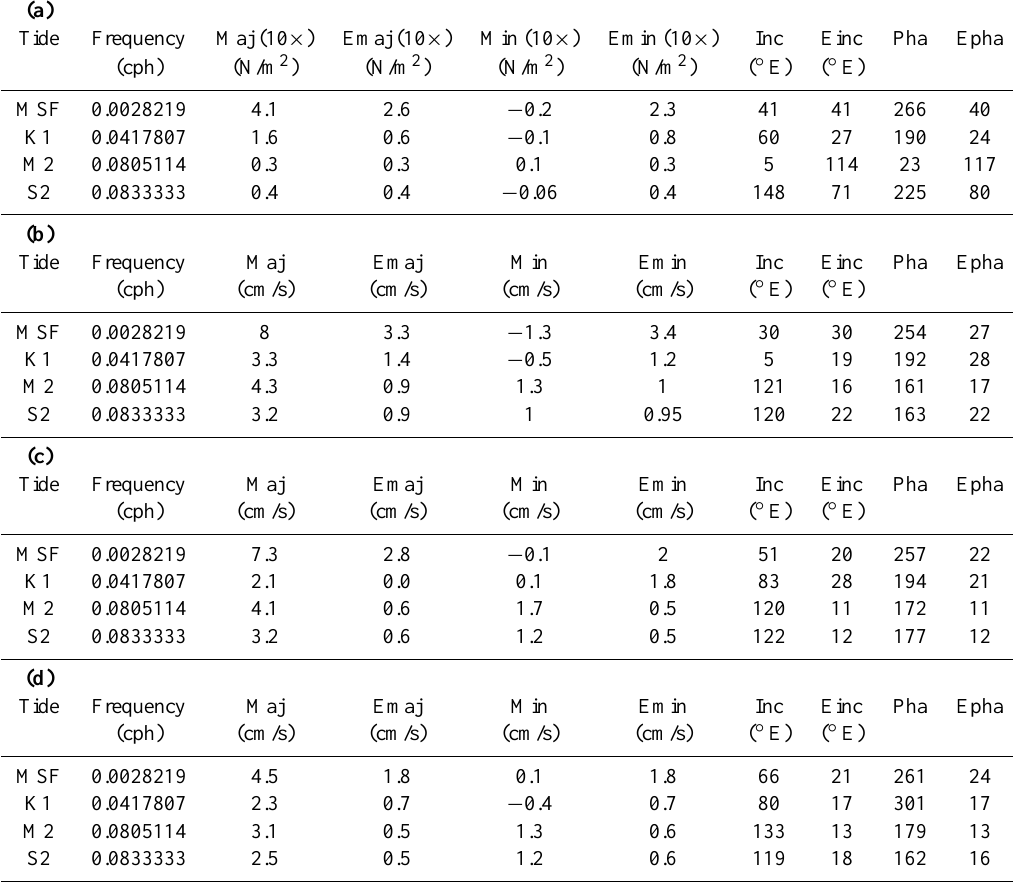
Table 2. Tidal ellipses parameters (major and minor axis, inclination and phase) together with 95% confidence levels (Emaj, Emin, Einc, Epha) for the dominant (Msf, K1, M2, S2) tidal constituents. Panel (a) refers to wind stress vector, while panels (b) , (c) and (d) refer to